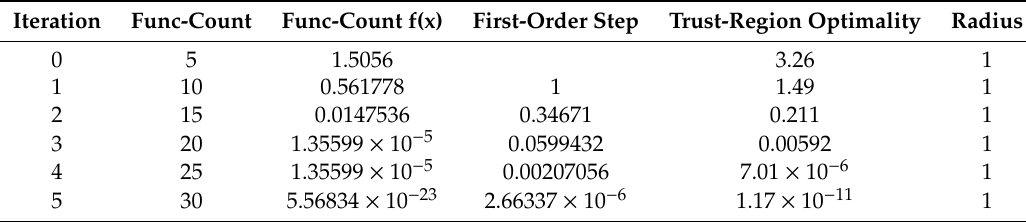
Table 1. Calculation parameters and metrics.